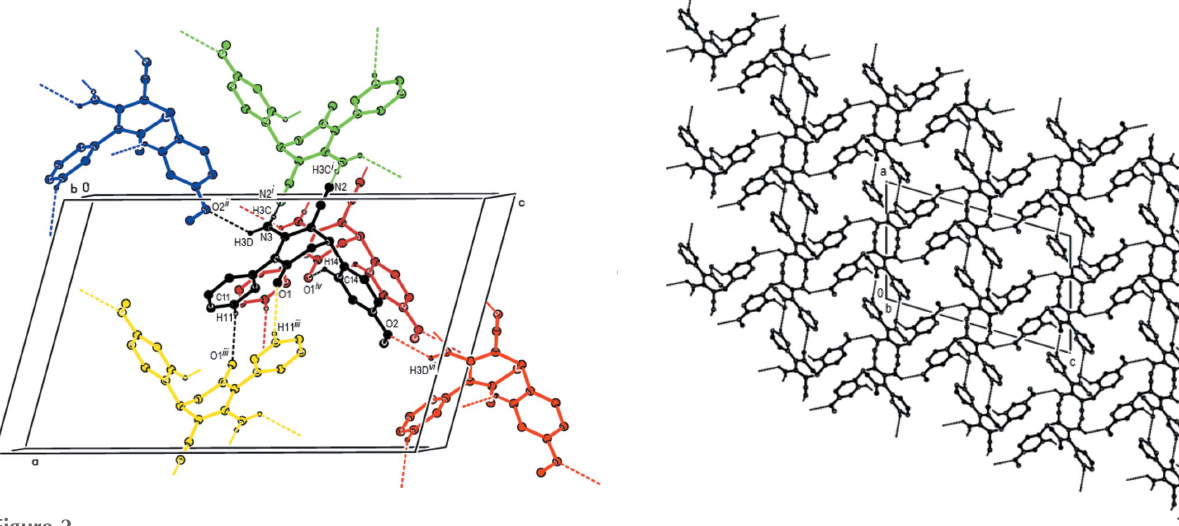
Figure 2 A general view of the N—H (cid:2)(cid:2)(cid:2) N, N—H (cid:2)(cid:2)(cid:2) O and C—H (cid:2)(cid:2)(cid:2) O hydrogen bonds in the crystal packing of the title compound [symmetry codes: (i) (cid:4) x , (cid:4) y , (cid:4) z + 1; (ii) x (cid:4) 1 , (cid:4) y + 1 , z (cid:4) 1 ; (iii) (cid:4) x + 1, (cid:4) y + 1, (cid:4) z + 1; (iv) x , 2 2 2 (cid:4) y , 1 y (cid:4) 1, z ; (vi) 1 + x , 1 + z ]. 2 2 2